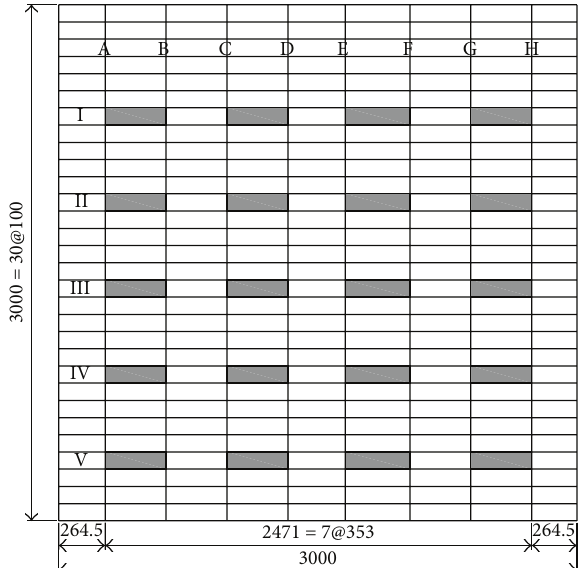
Figure 11: A plan view of the 353 × 100 mm test point grid for the S-wave measurement. The test was carried out at the shaded areas in the grid